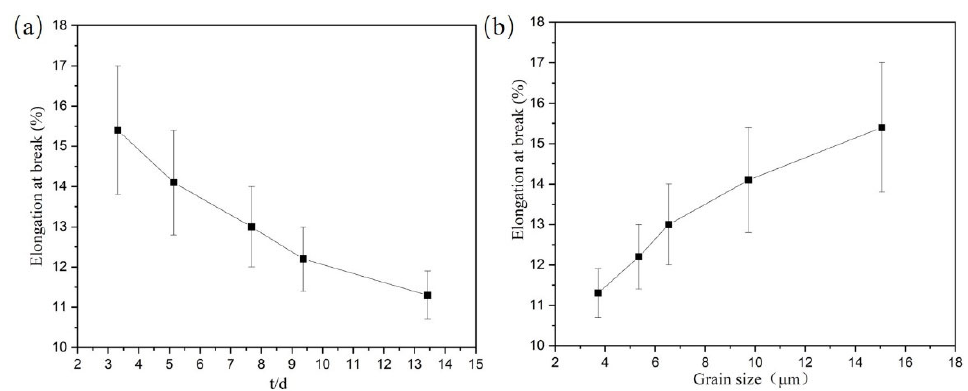
Figure 3. The variation of the elongation of Ti ‐ 2.5Al ‐ 1.5Mn: ( a ) with t/d value, ( b ) with grain size.